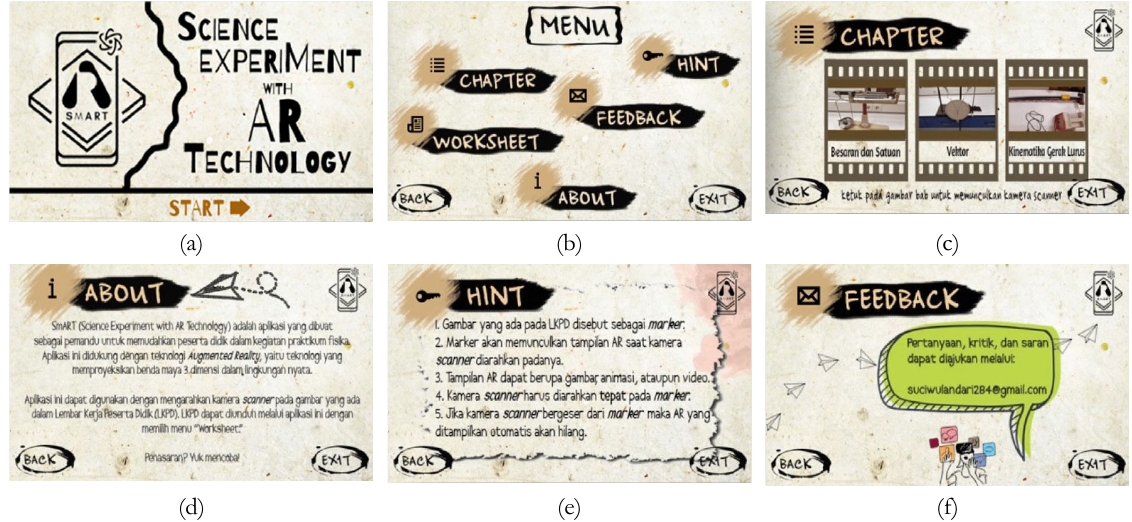
Figure 2. (a) start page, (b) menu page, (c) chapter main page, (d) about page, (e) hint page, (f) feedback